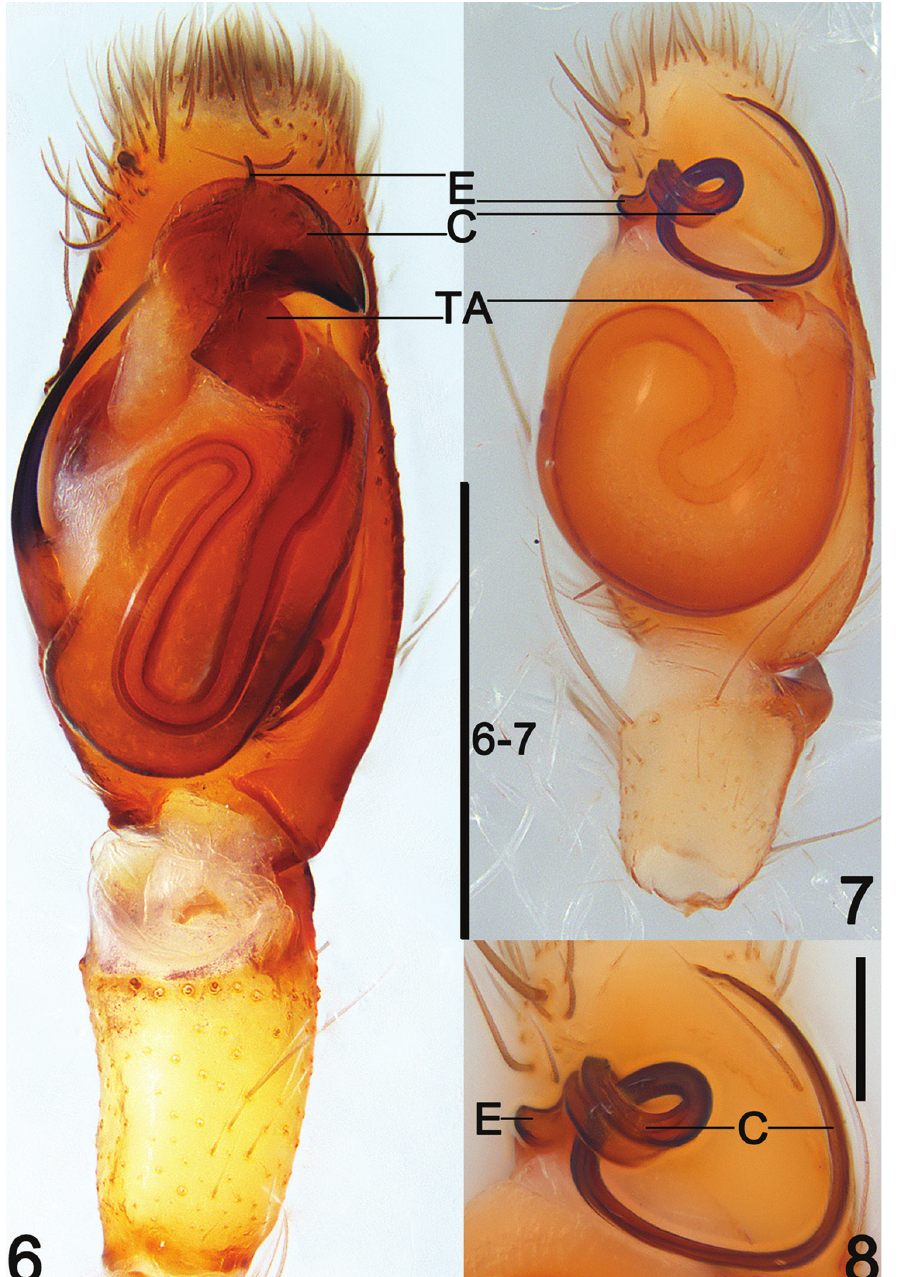
Figures 6–8. Left male palp of Clubiona grucollaris sp. n. and C. filicata O. Pickard-Cambridge, 1874, ventral view. 6 C. grucollaris sp. n., male holotype 7 C. filicata O. Pickard-Cambridge, 1874, male from Guangxi, China 8 C. filicata O. Pickard-Cambridge, 1874 from Guangxi, China, apical appendage of tegulum, ventral. Scale bars 0.5 mm ( 6–7 ); 0.1 mm ( 8